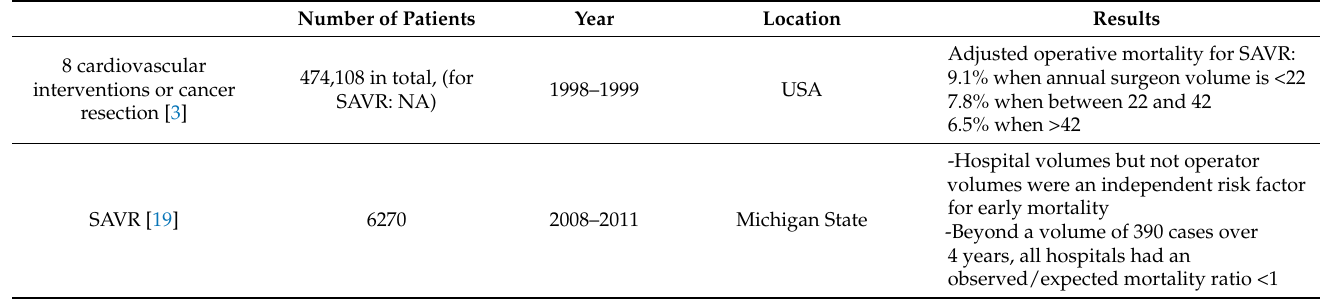
Table 2. Studies assessing the volume-outcome relationship for aortic valve